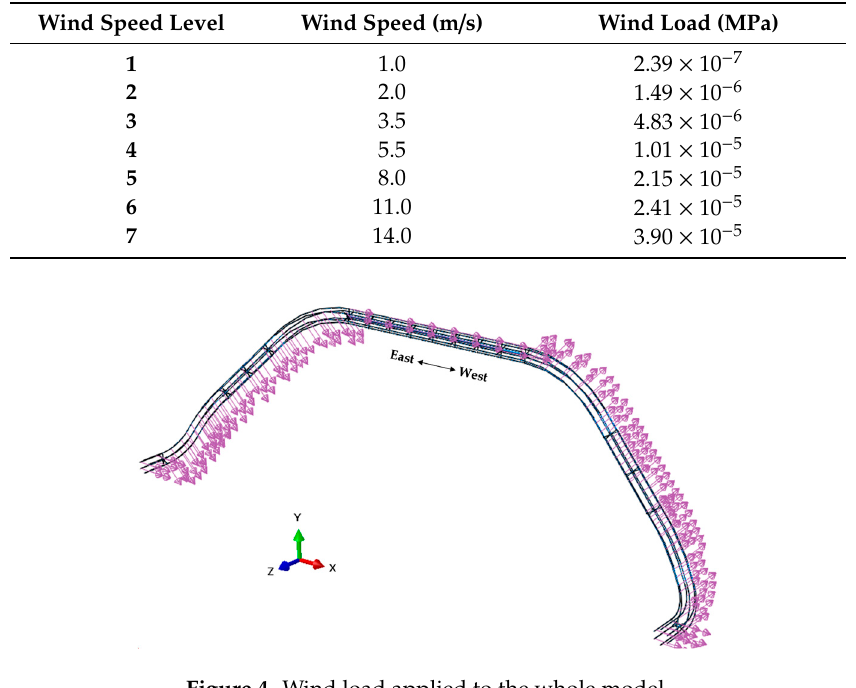
Figure 4. Wind load applied to the whole model.